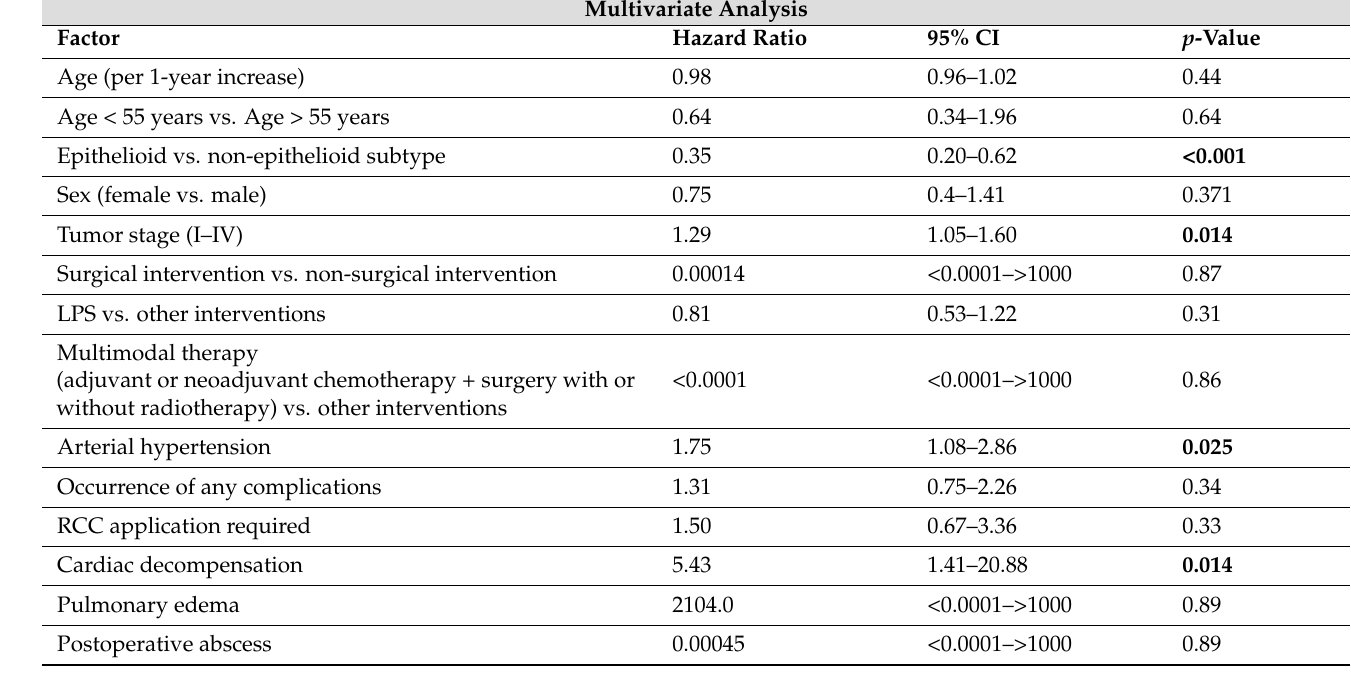
Table 7. Multivariate analysis of factors that had a significant impact on patients’ survival in the univariate analysis. The p -values and hazard ratios were determined by multivariate Cox regression. LPS lung-preserving surgery, RCC red cell concentrate; statistically significant p -values were printed in